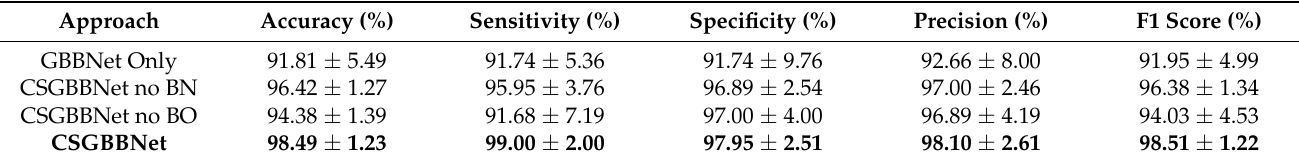
Table 7. Results of our ablation study.